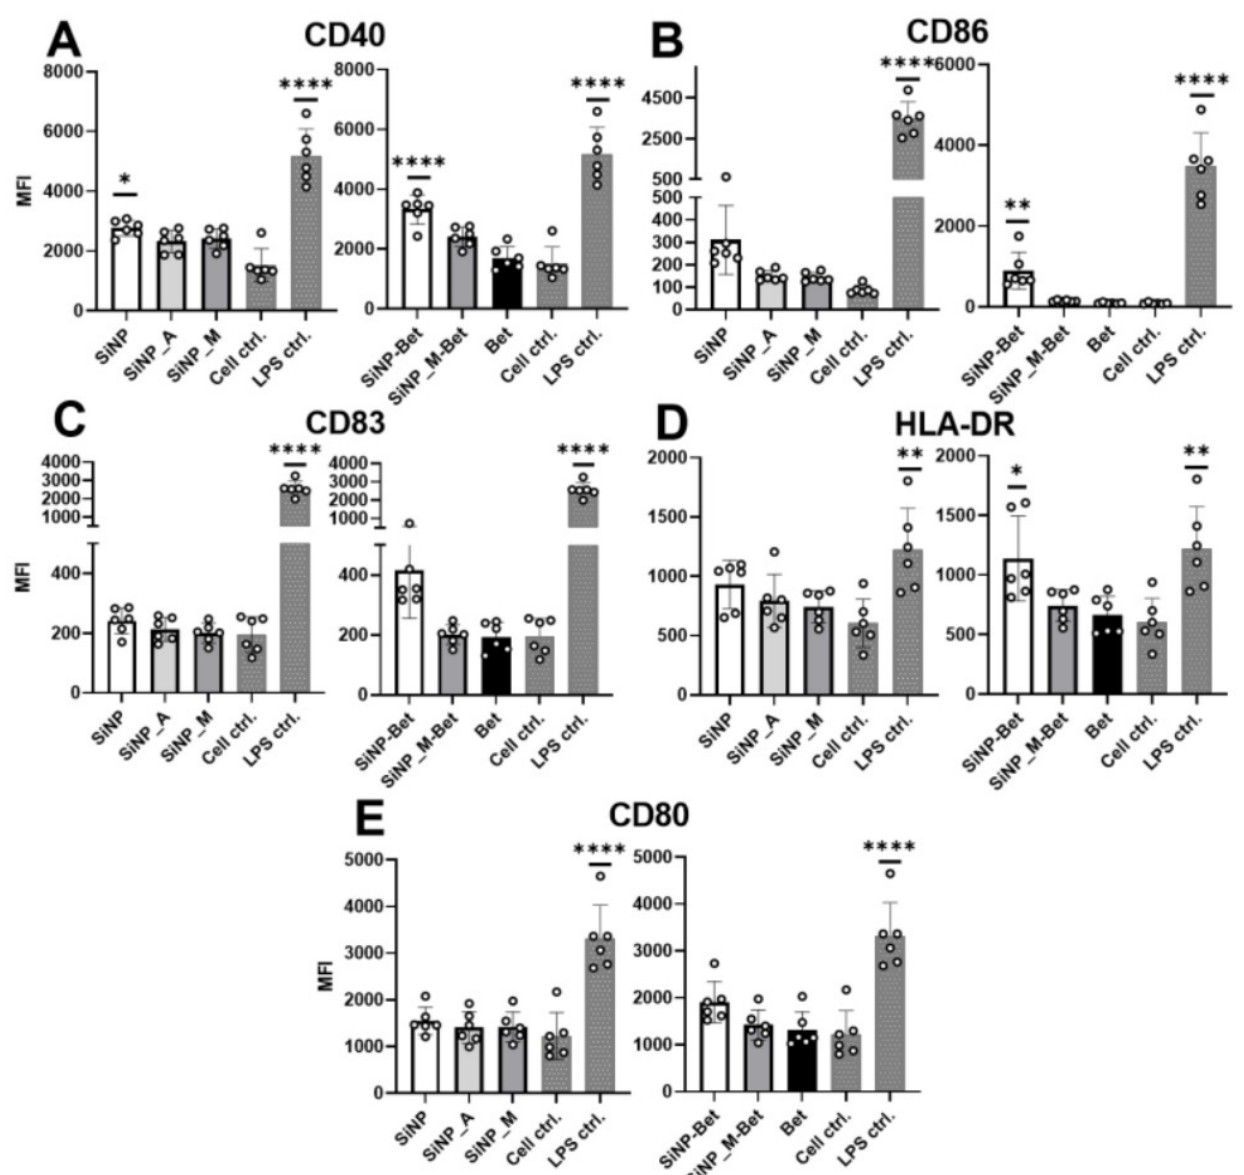
Figure 6. Co-stimulatory molecule expression by stimulated moDCs with functionalized SiNPs and Bet. ( A ) CD40, ( B ) CD86, ( C ) CD83, ( D ) HLA-DR, and ( E ) CD80 were analyzed. LPS was used as the